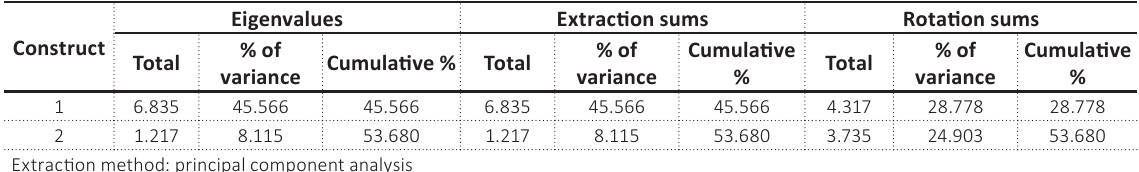
Table 8. Summary of total variance